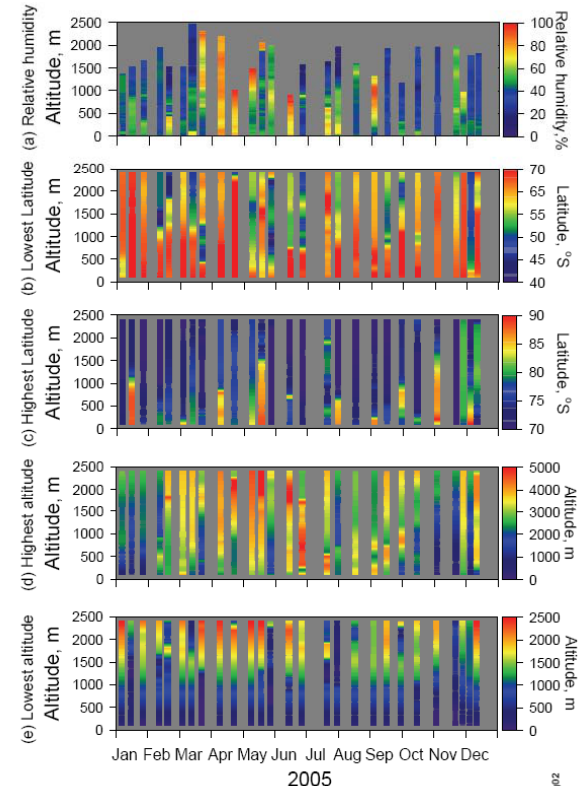
Fig. 2. Seasonal and vertical features of relative humidity and air mass history at Syowa Station, Antarctica: (a) relative humidity, (b) the lowest latitude in 5-day backward trajectory, (c) the highest latitude, (d) the highest altitude, and (e) the lowest altitude. Rela- tive humidity was measured by tetheresonde. Y-axis height means start altitude in the trajectory and colour contour indicates air mass history calculated in the